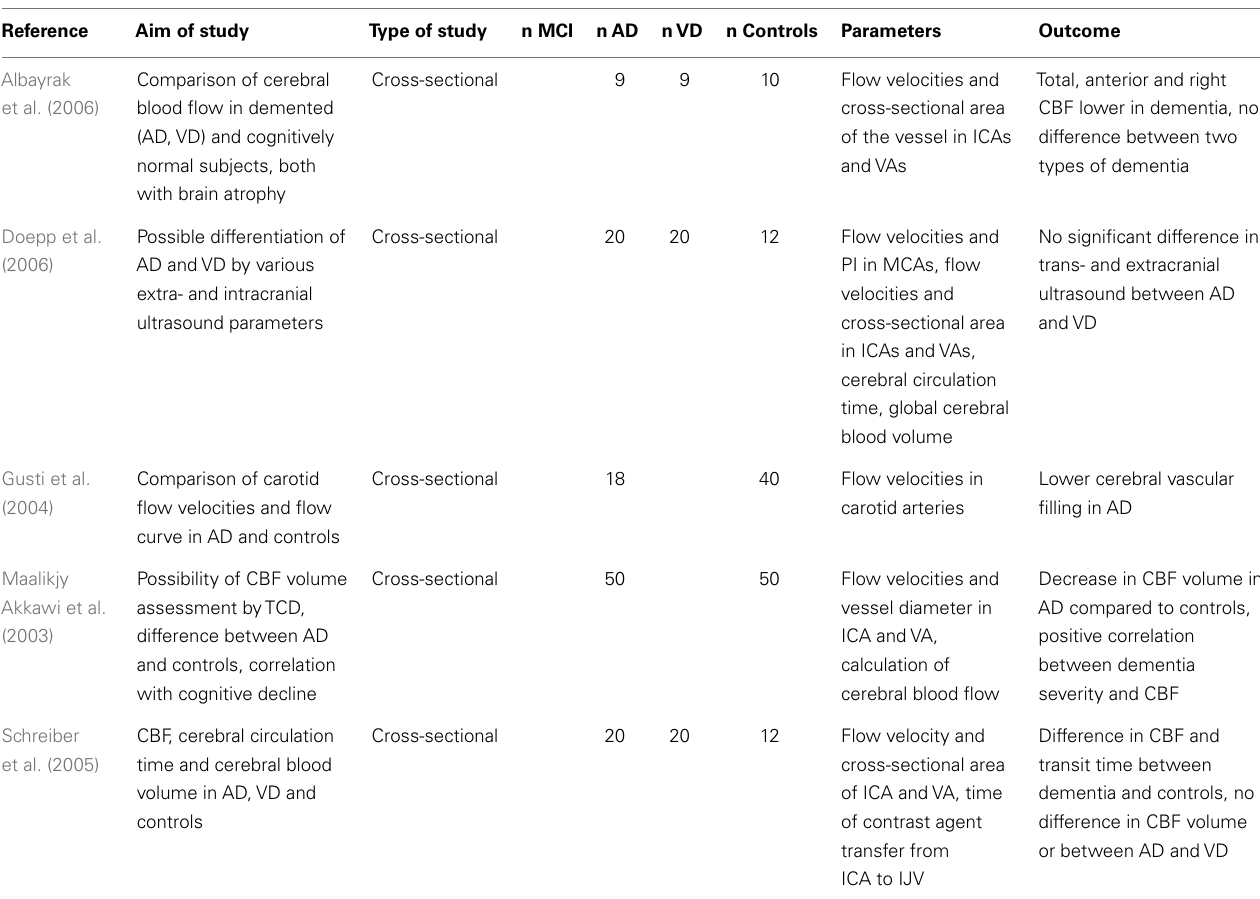
Table 2 |Total cerebral blood